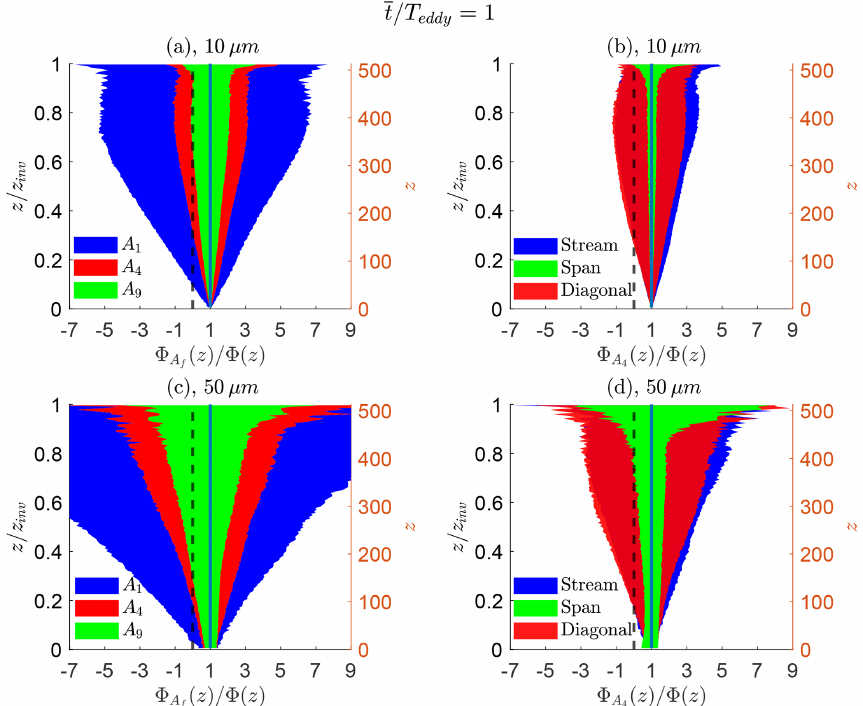
Figure 8. Vertical profiles of flux ranges in sampled (a, b) 10µm and (c, d) 50µm aerosol particle fluxes for a time-averaged duration of 1 T eddy . The directional sampling (b, d) is for a sampling area of A 4 . Colors from Fig. 6 correspond to those in the current figure. The dashed black line is the zero value reference of net flux, while the solid black line is the reference value for the sampled aerosol particle flux equal to the true, domain-wide LES aerosol particle